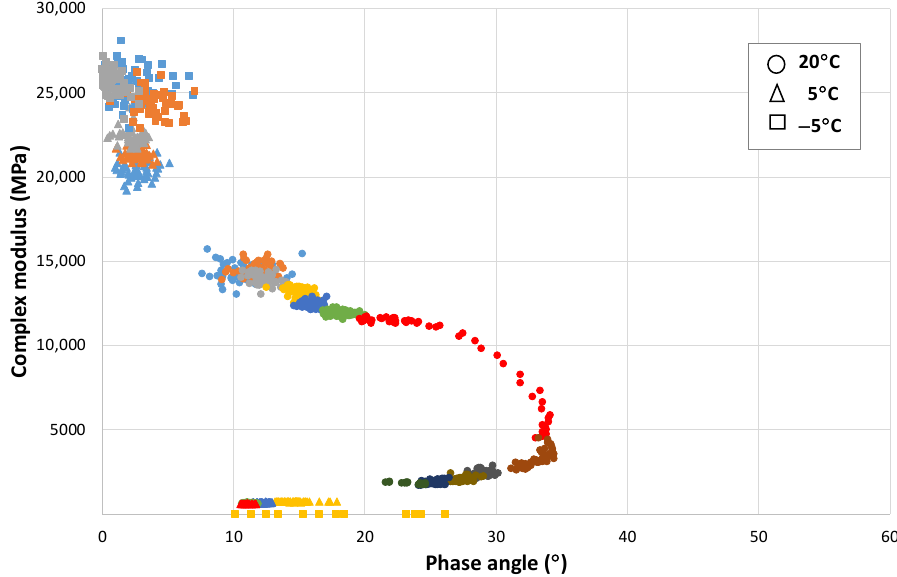
Figure 11. Variation of the modulus with the phase angle. Aged AC16 50/70 S mixture.